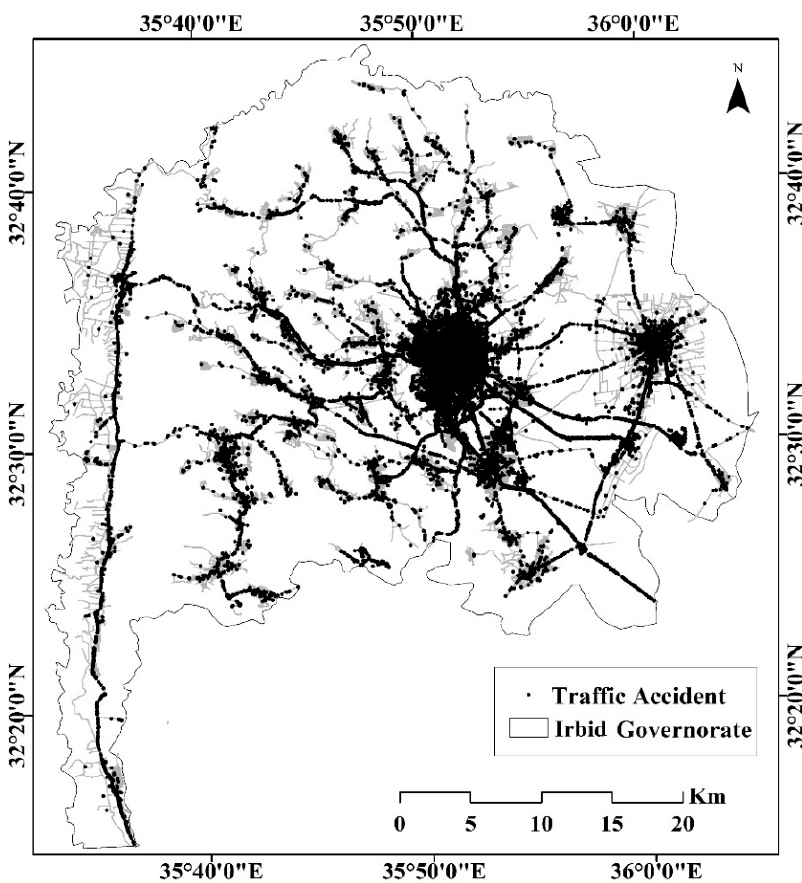
Figure 4. Spatial distribution map of traffic accidents in the Irbid Governorate during 2015–2019.